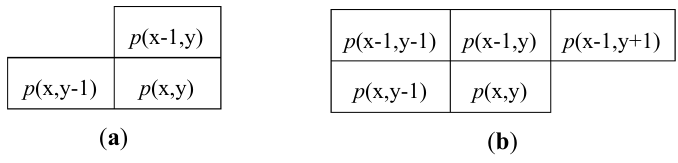
Figure 2. A 4-connected ( a ) and an 8-connected ( b ) neighborhood for raster scan-based CCL.